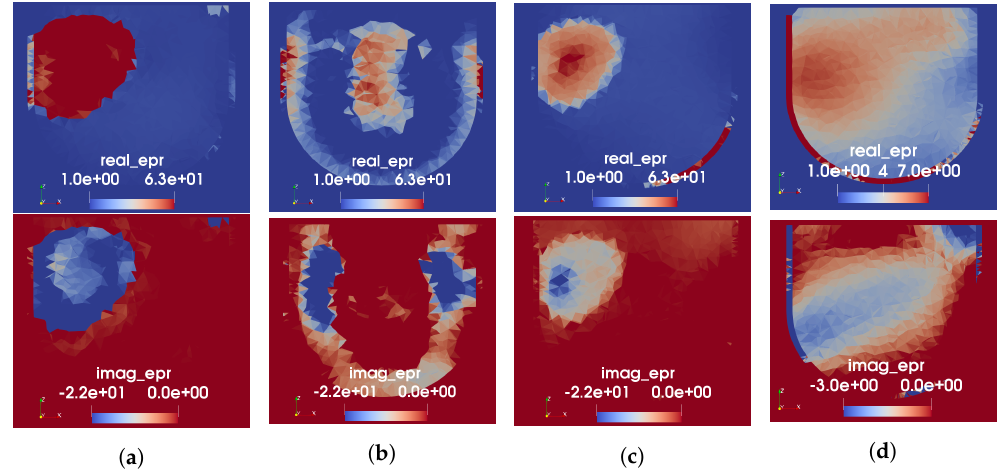
Figure 8. FEM-CSI reconstructions at 1.0 GHz for Phantom 1. ( a ) Initial guess from segmented map- ping. ( b ) Initial guess from linear mapping. ( c ) Initial guess from tissue-range mapping. ( d ) Perfect prior of skin and fat only (no